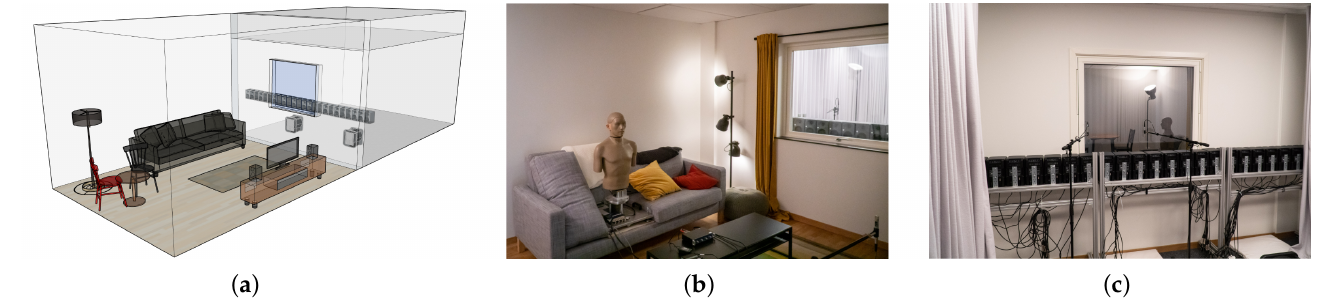
Figure 2. Model of Living Room Lab ( a ), listening room with artificial head at participant position ( b ) and loudspeaker array setup behind window in transmitting room ( c